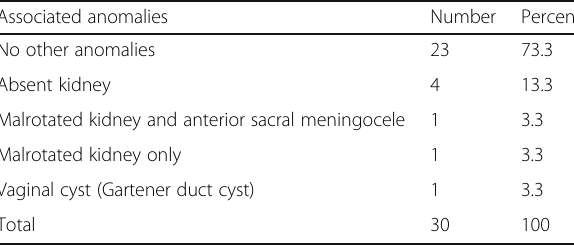
Table 3 The associated anomalies with the Mullerian duct abnormalities in the study group